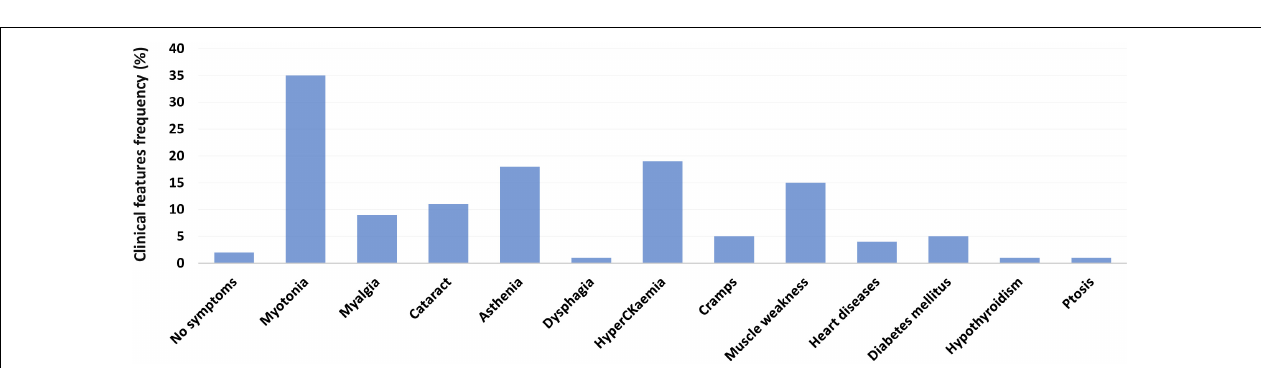
FIGURE 1 | Pie chart showing the frequency of myotonic dystrophy type 2 (DM2)-positive, DM2-negative, and DM2-premutated with sex distribution in each category.